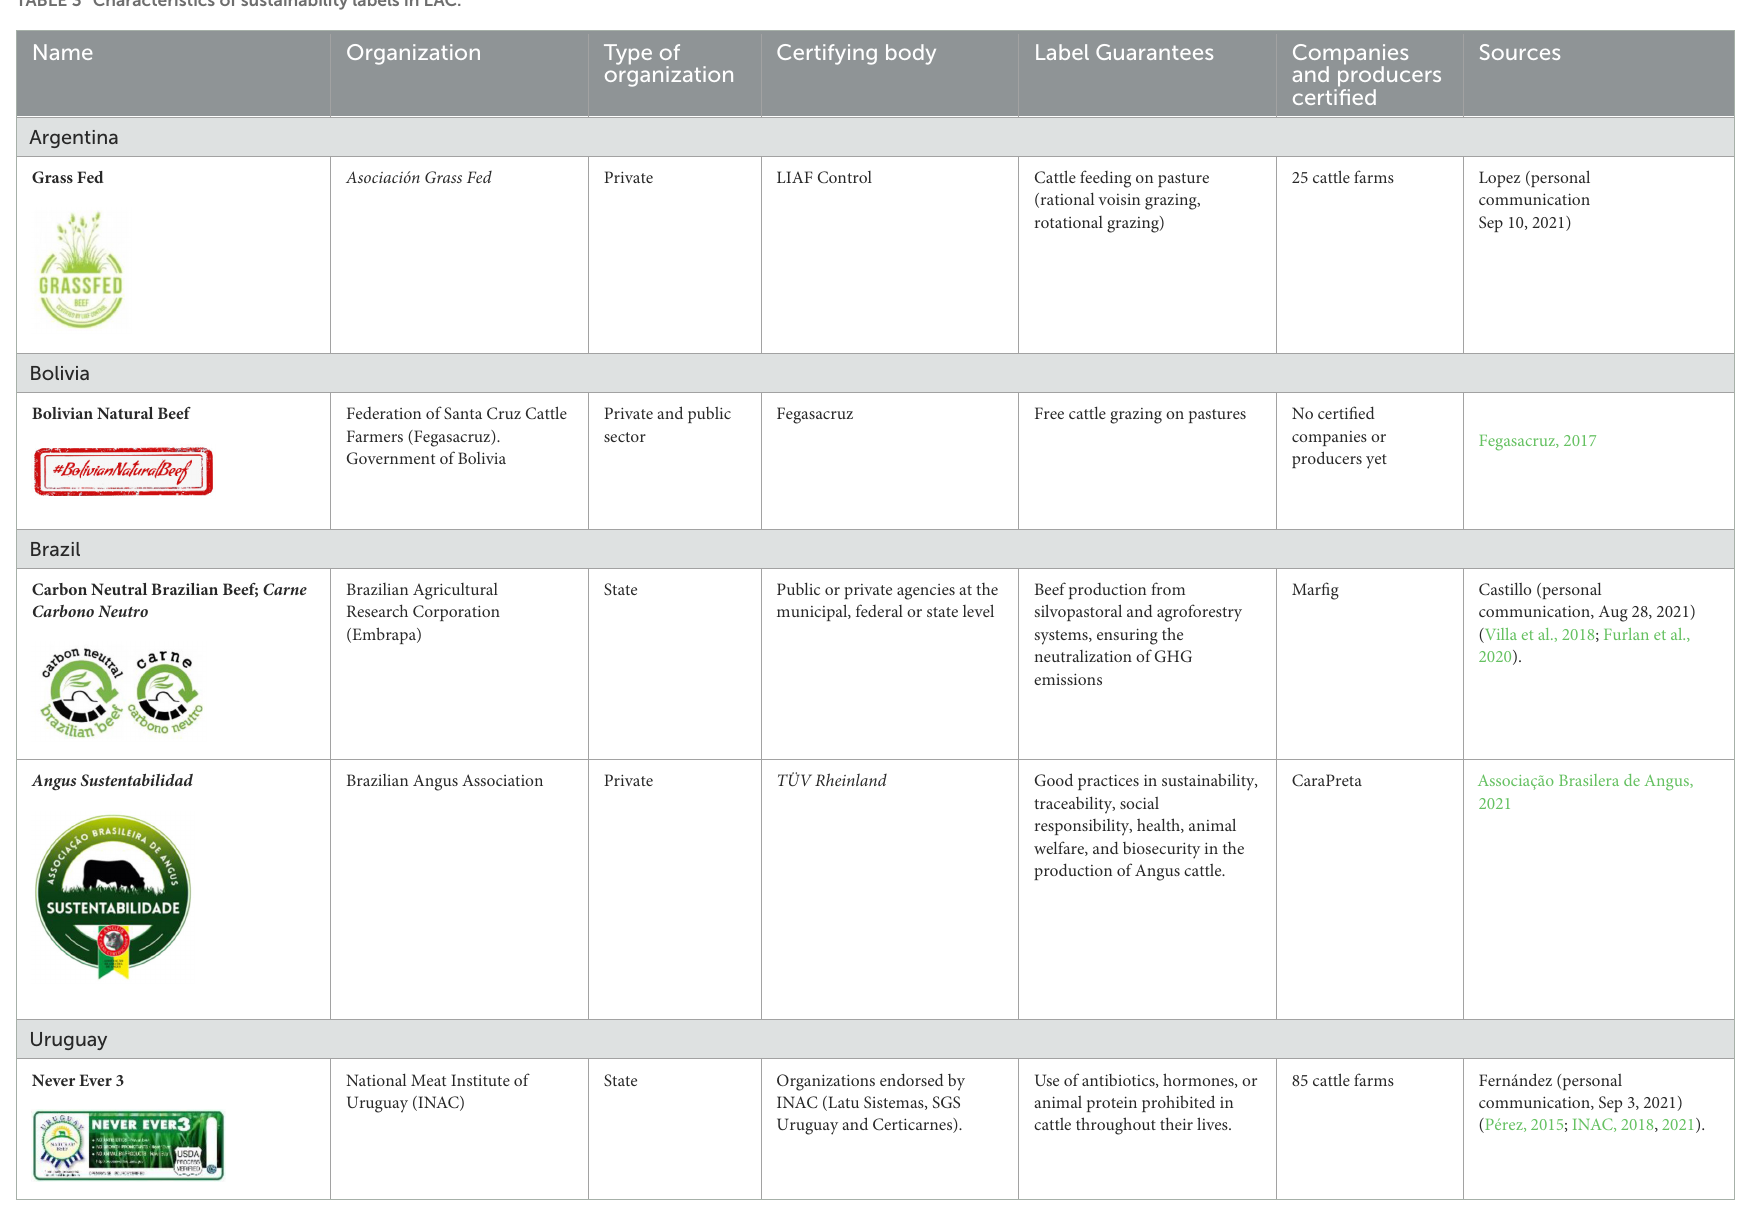
TABLE 3 Characteristics of sustainability labels in